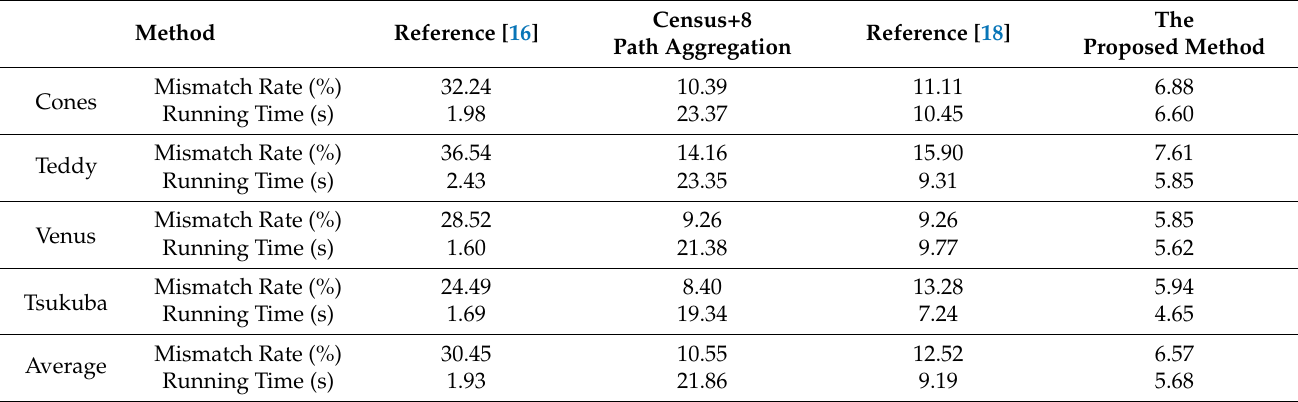
Table 3. Comparison table of disparity map evaluation indicators obtained by different algorithms.